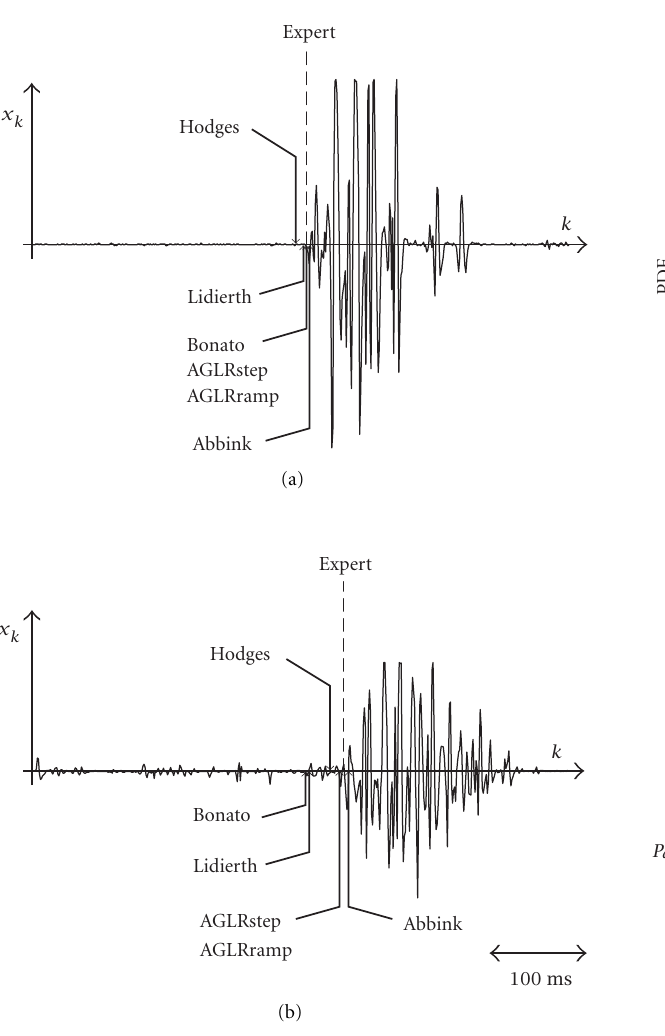
Figure 8:RawSEMGsignalsobtainedinareactiontimeexperiment: two sample traces (a) and (b) with different SNR. Onset estimates of each method are indicated by markers. Dotted lines indicate the expert’s reference.